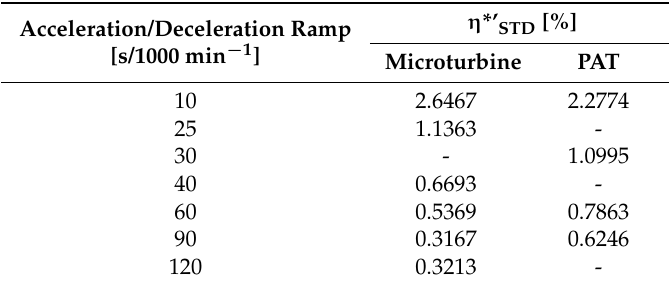
Table 6. Resulting STD values of the efficiency fluctuation depending on the acceleration/deceleration ramp.